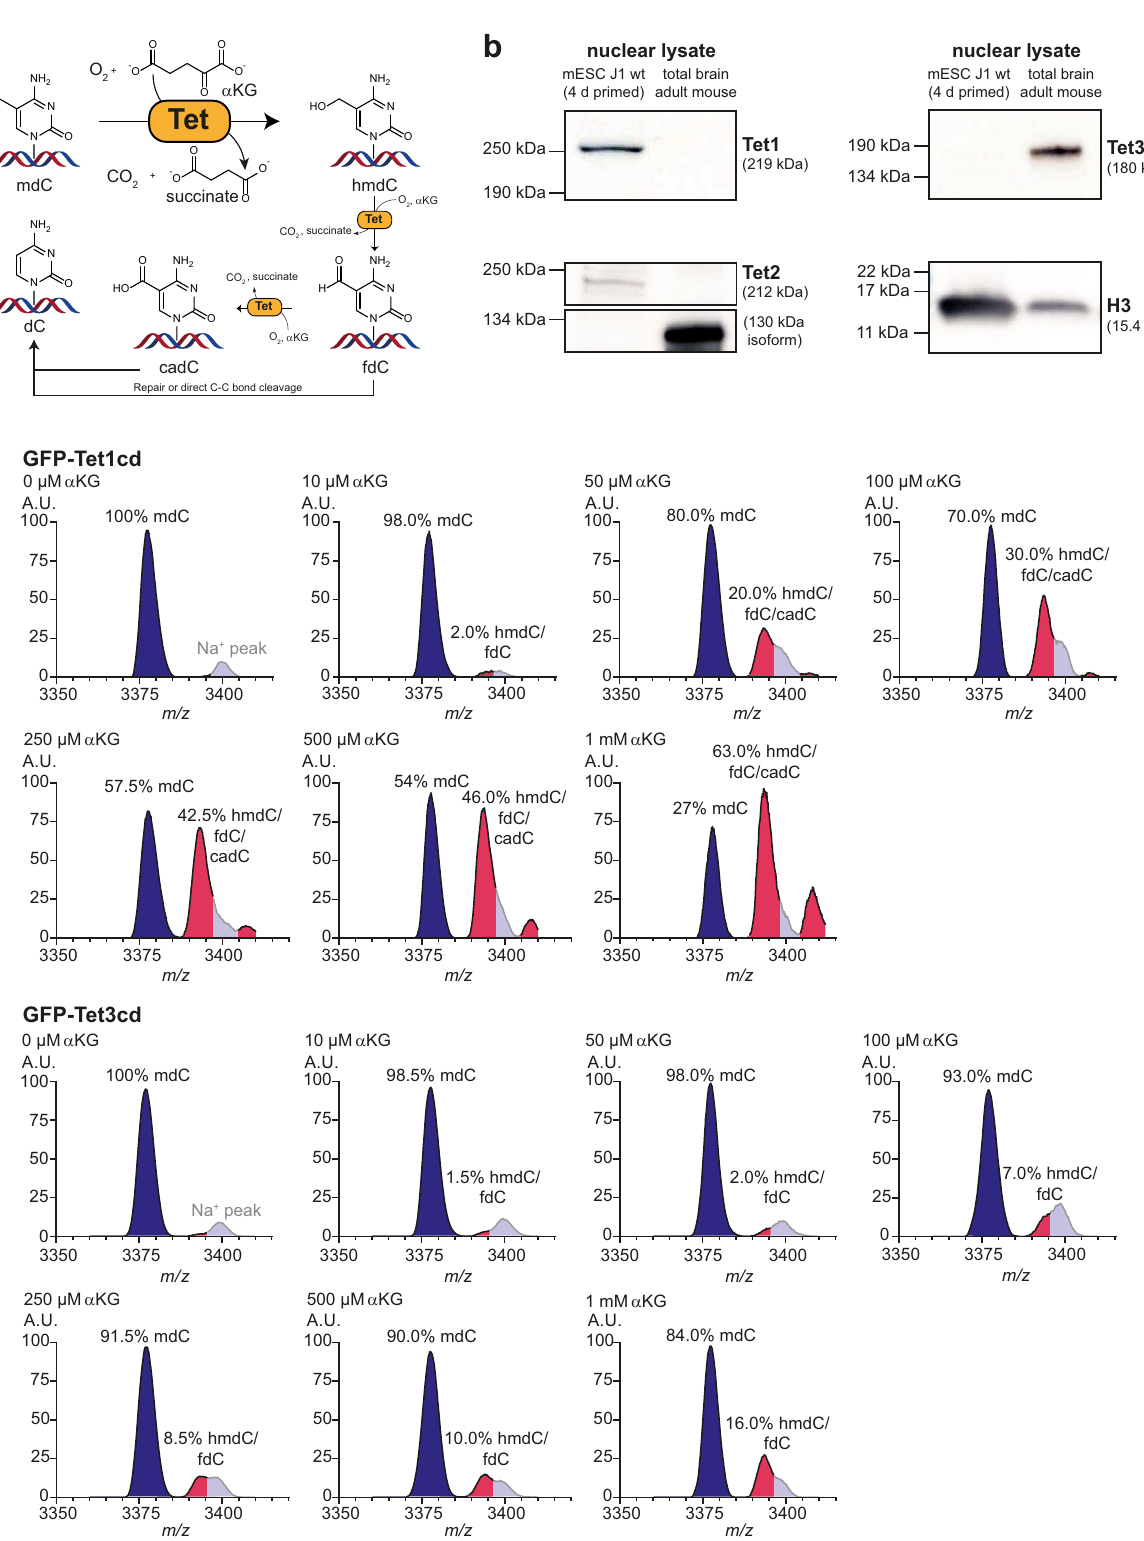
Fig. 1 Tet enzyme kinetics. a Illustration of α KG and O 2 -dependent mdC-oxidation to hmdC and further on to fdC and cadC by Tet enzymes, with hmdC being the main oxidation product. FdC and cadC can be fi nally replaced by unmodi fi ed dC. b Western blots against Tet1, Tet2, and Tet3 in nuclear lysate of mESCs compared to murine brain. c MALDI-TOF MS spectra ( n = 3 independent experiments, spectra show mean) of a single-stranded DNA oligonucleotide containing mdC (blue and Na + peak in gray) that is oxidized to hmdC, fdC, and cadC (magenta) by GFP-Tet1cd or GFP-Tet3cd in the presence of increasing α KG concentrations. A.U. arbitrary units, m/z mass to charge ratio. Source data are provided as a Source Data fi